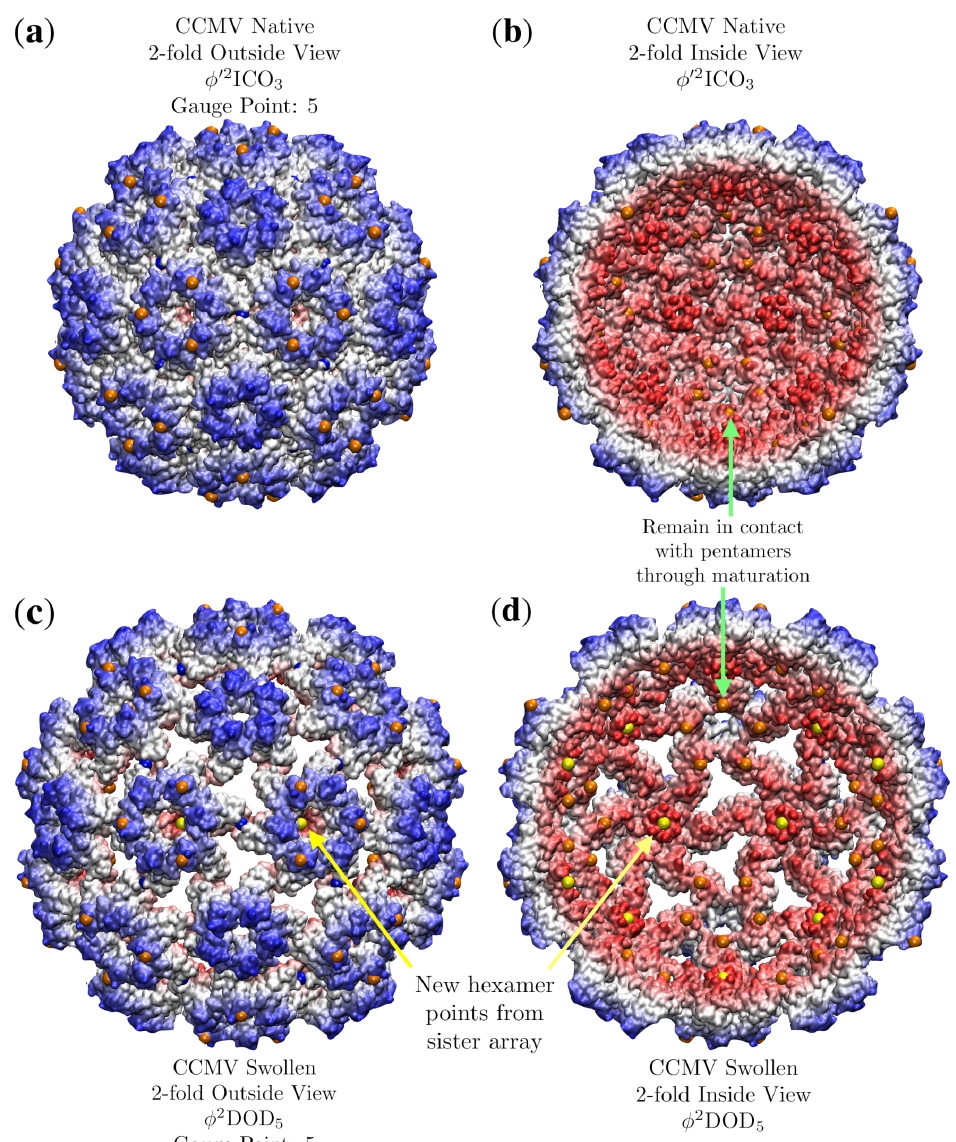
Figure 18. A comparison of the structural changes of CCMV ( T = 3 ) which occur during maturation using point arrays. Each capsid is radially colored. ( a ) Exterior view of CCMV native state, showing the prominent role that hexameric features play in determining the point array fit. ( b ) The interior of CCMV natives state. There are point array locations (orange) in contact with the interior surface of the pentamer, as was seen in Figure 17. ( c ) The swollen CCMV capsid is approximately a uniformly scaled native state, though the orientation of the hexamer chains rotate slightly and the center of the hexamer opens up at the top and closes at the bottom, allowing the sister point array φ 2 DOD 5 to fit the capsid. The overall effect of this reorganization is to create holes in the protein capsid. ( d ) The interior view of the mature capsid showing how the hexamer unit changes to accommodate a new point (yellow) after